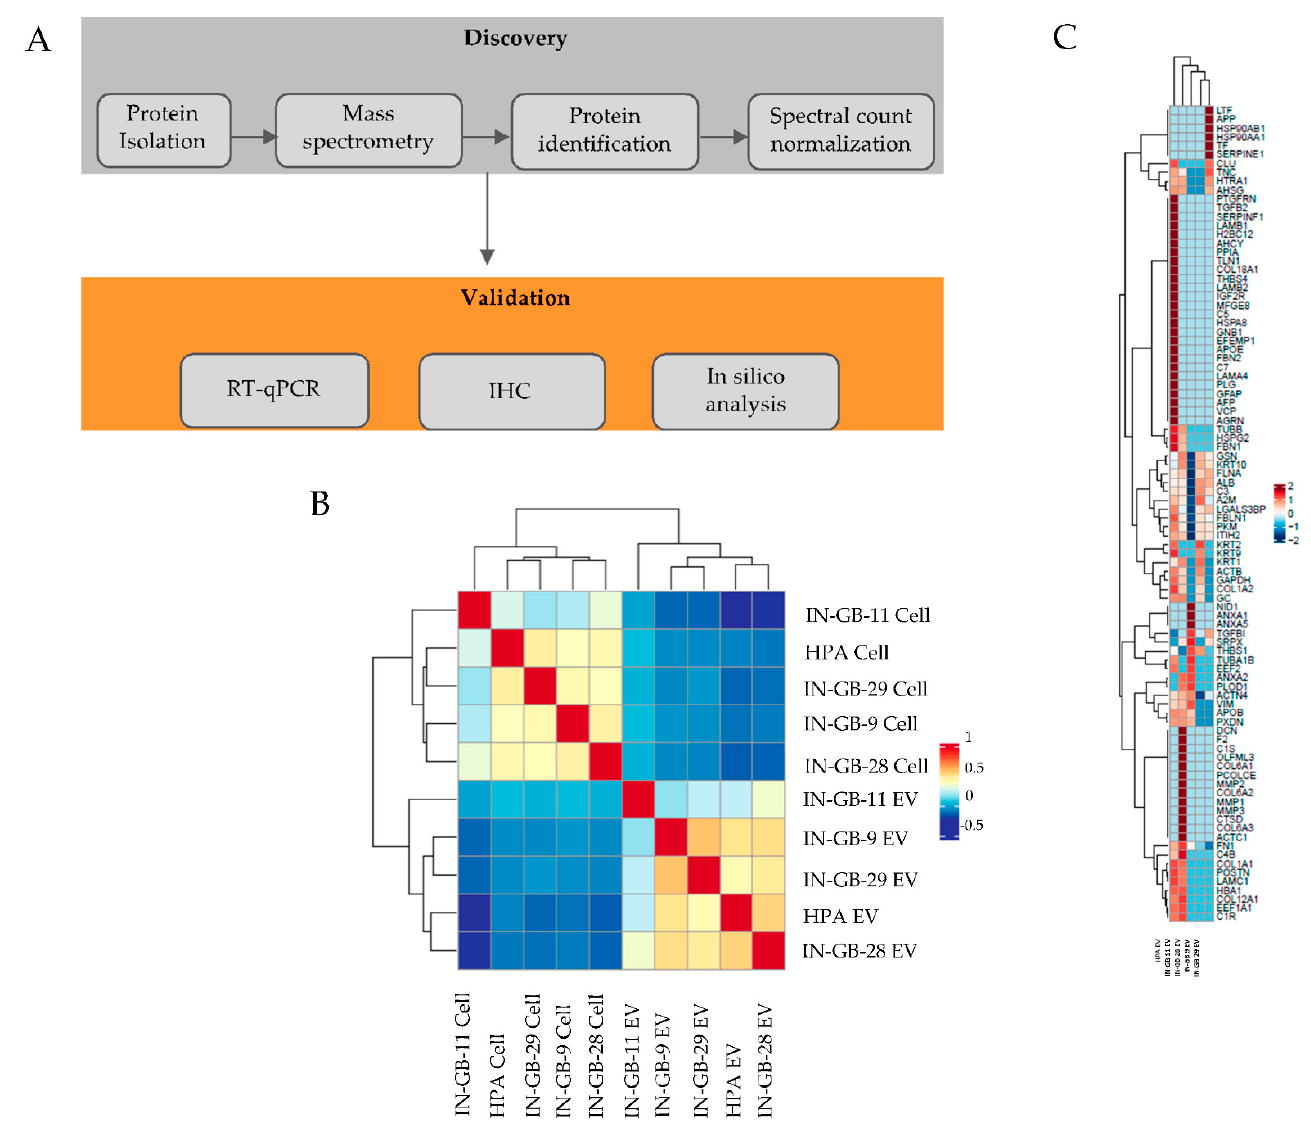
Figure 1. Experimental design. ( A ) Schematic depiction of experimental strategy to discover and validate glioblastoma-specific tumors; ( B ) Correlation of protein expression between EVs and their parental cell lines; ( C ) Heatmap showing the 92 proteins specific to EVs.